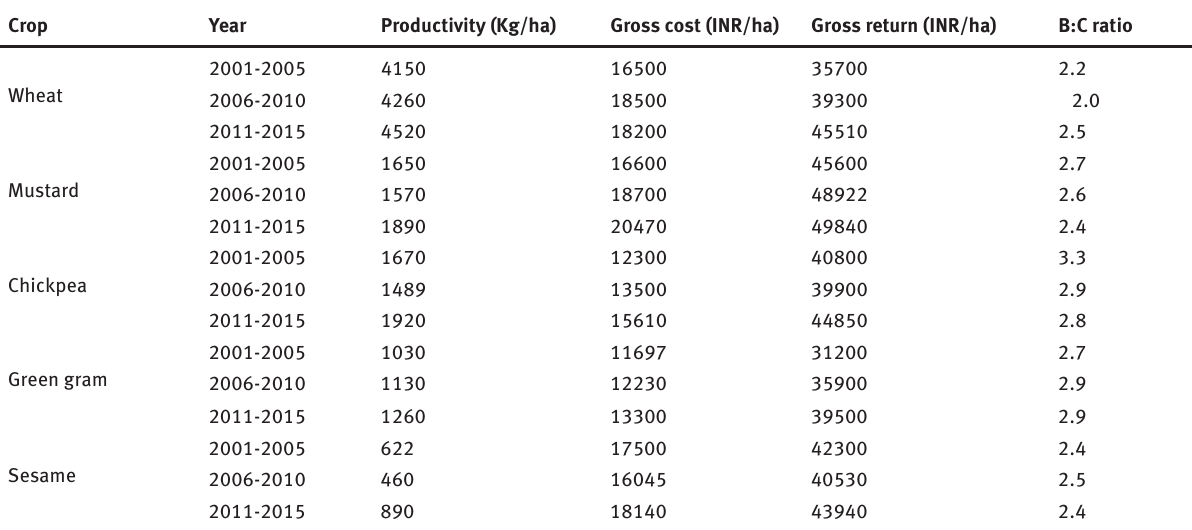
Table 1: Productivity and economics of different crops cultivated